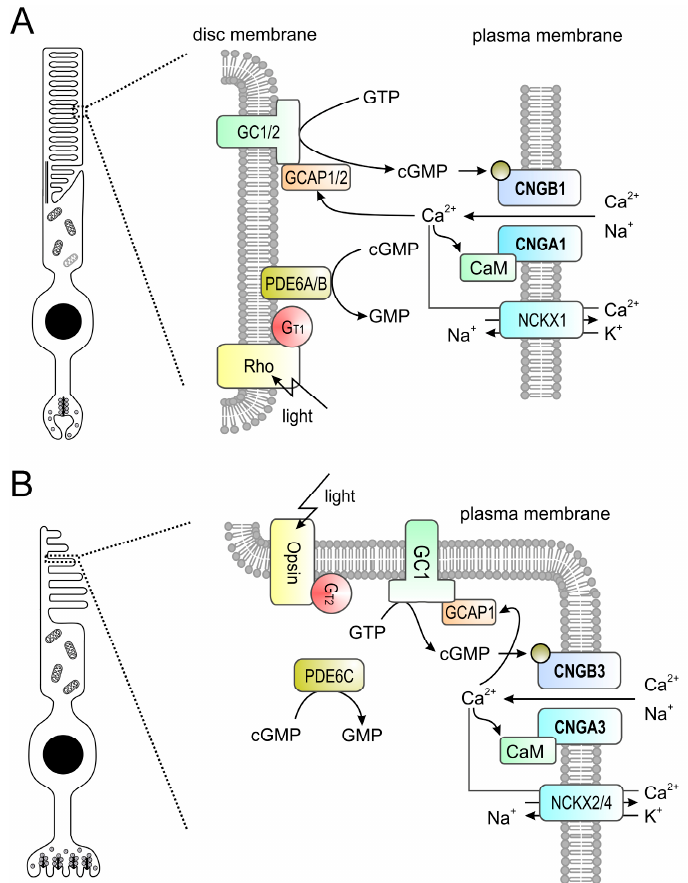
Figure 2. ( A , B ) Phototransduction in mouse rod ( A ) and cone ( B ) outer segments. The principle of the phototransduction is similar in both cell types. In the dark, the cyclic nucleotide-gated (CNG) channel (CNGA1/B1 in rods and CNGA3/B3 in cones) of the outer membrane is kept open by high concentrations of cyclic guanosine monophosphate (cGMP) produced by retinal guanylyl cyclases (GCs) 1 and 2 (GC1/2 in rods, GC1 only in cones) present in the disc membrane. The resulting influx of Na + and Ca 2+ depolarizes the plasma membrane. Light activates rhodopsin (Rh) which in turn activates transducin (G t1 in rods, G t2 in cones) whose alpha subunit activates a phosphodiesterase (PDE6A/B in rods, PDE6C in cones) leading to hydrolysis of cGMP. The drop in the cGMP concentration leads to the closure of the CNG channel yielding to membrane hyperpolarization. Ca 2+ is an important regulator of phototransduction. At high concentrations Ca 2+ binds to guanylyl cyclase-activating proteins (GCAPs; GCAP1/2 in rods, GCAP1 only in cones) leading to an inhibition of guanylyl cyclases. High levels of Ca 2+ also lead to a slight reduction of the cGMP affinity of the CNG channel via CaM-mediated feedback inhibition. Ca 2+ is cleared from the outer segment via a Na + -Ca 2+ -K + -exchanger (NCKX1 in rods, NCKX2/4 in cones). At low Ca 2+ levels GCAPs switch to the Ca 2+ -free form that is an activator of GCs.